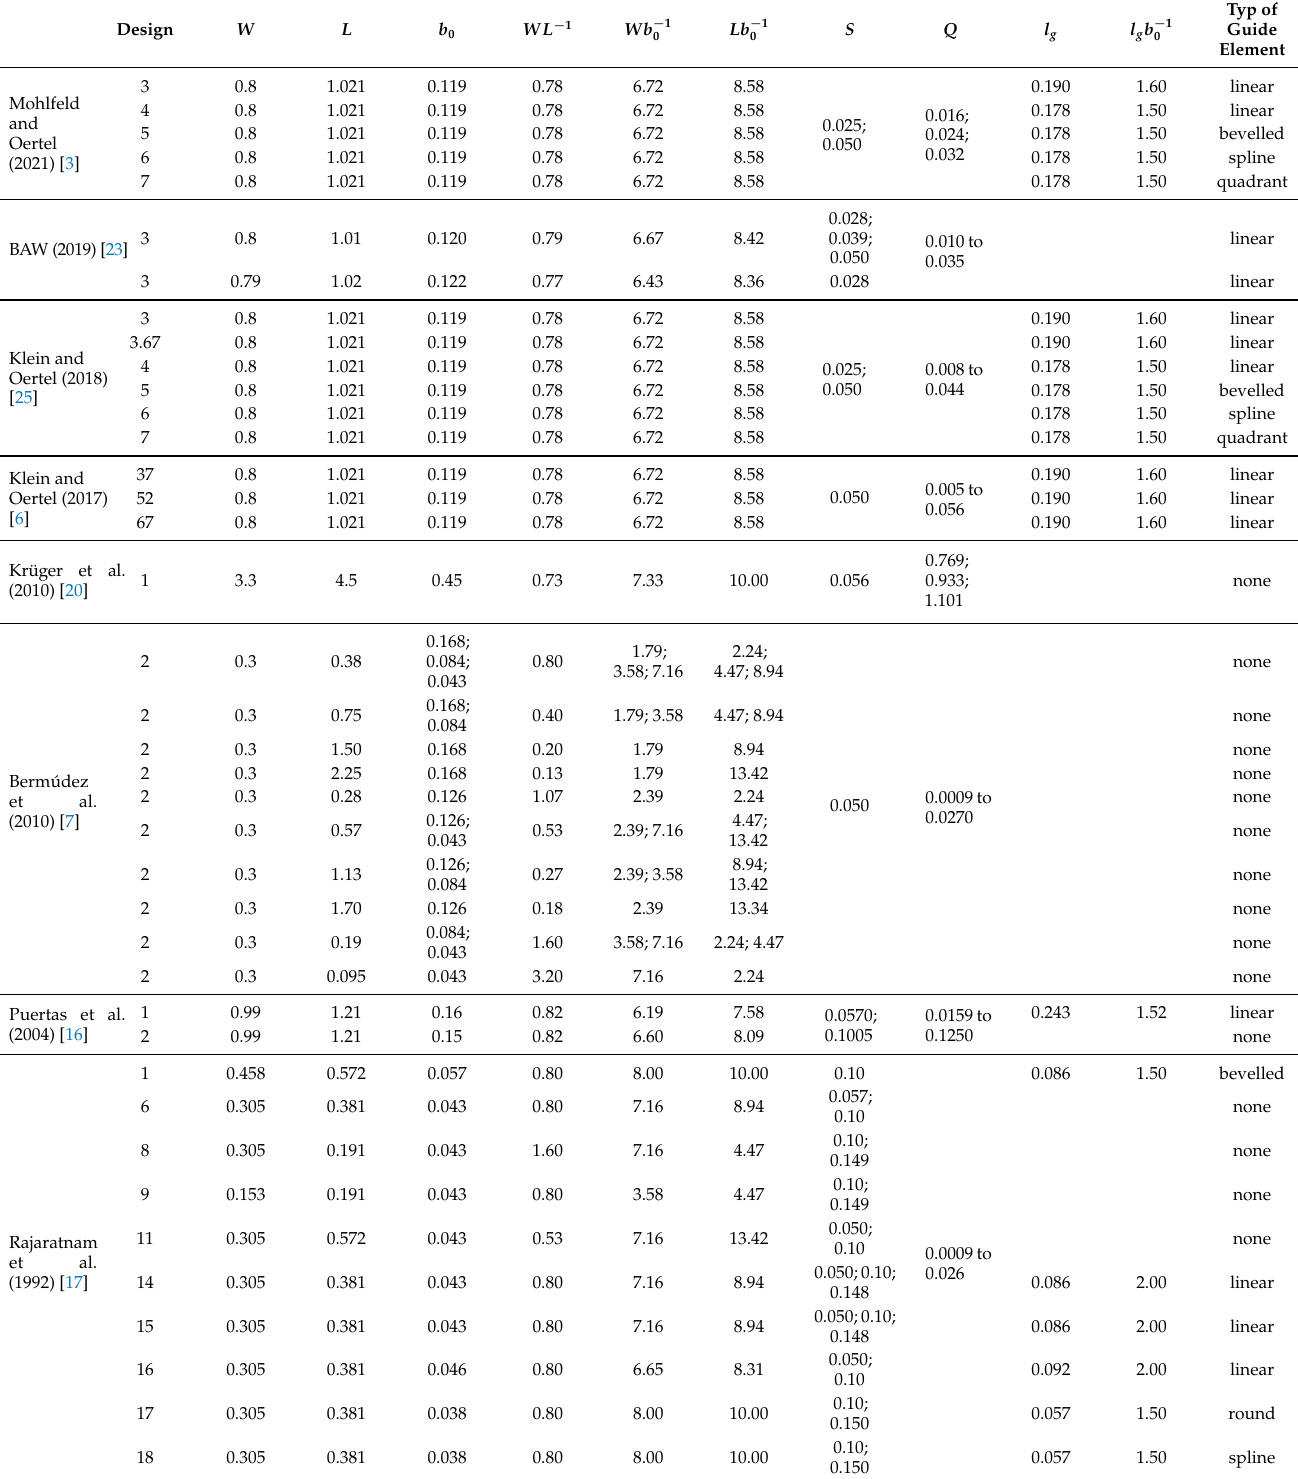
Table 1. Overview of experimental parameters from different